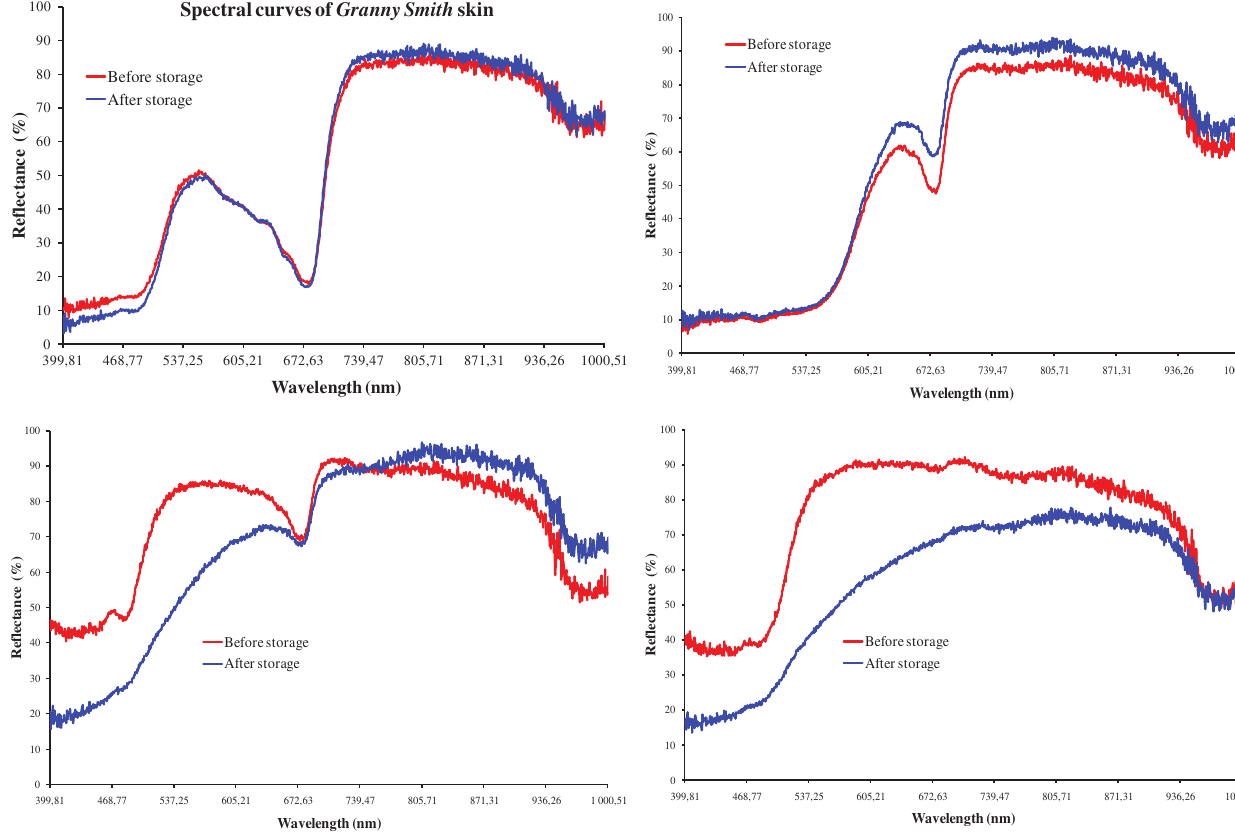
Figure 1. Changes of spectral curves due to the chilling